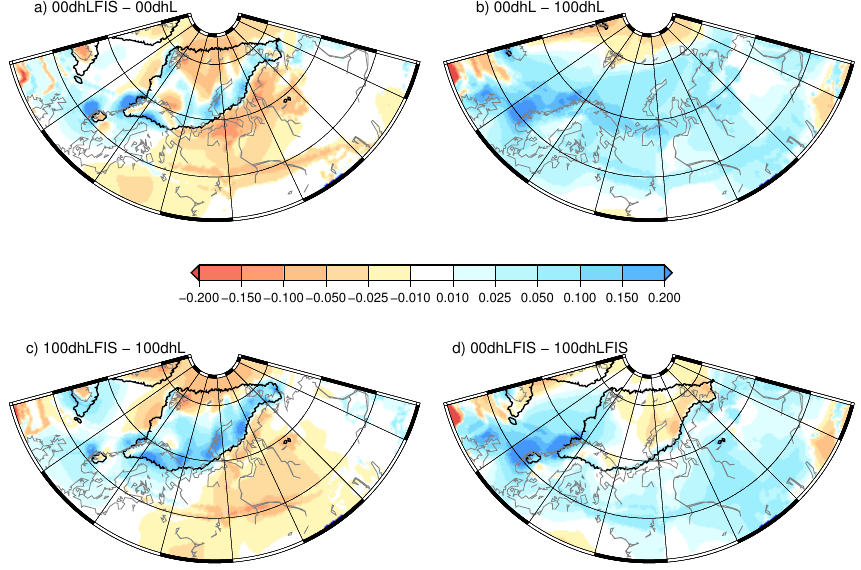
Figure 17. Differences in snow accumulation (in myr − 1 ) computed by the GRISLI ice-sheet model between (a) 00dhLFIS and 00dhL experiments (b) 00dhLFIS and 100dhL experiments, (c) 100dhLFIS and 100dhL experiments and (d) 00 and 100dhLFIS experiments.